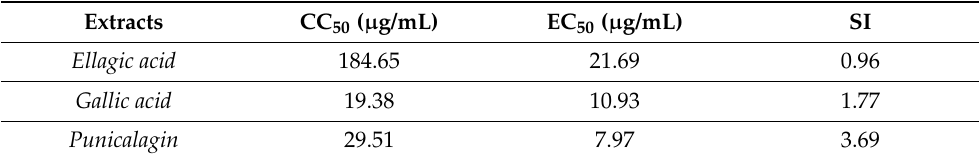
Table 4. Selectivity index (SI), cytotoxicity (CC 50 ), and antiviral activity (EC 50 ) of punicalagin, ellagic acid and gallic acid.